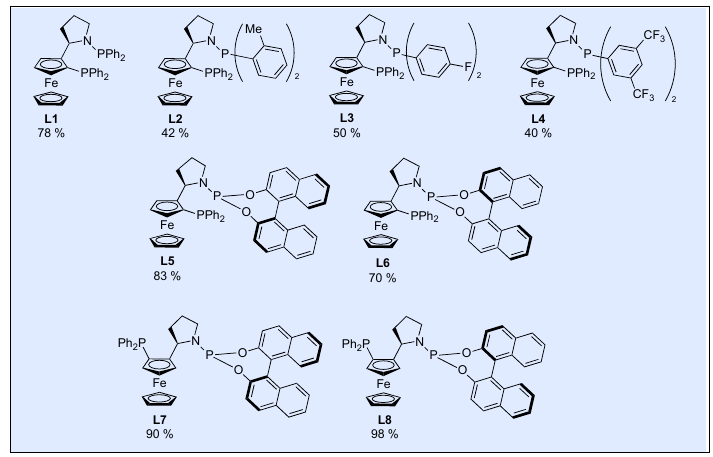
Scheme 2. Enantioselective synthesis of L1 – L8 .